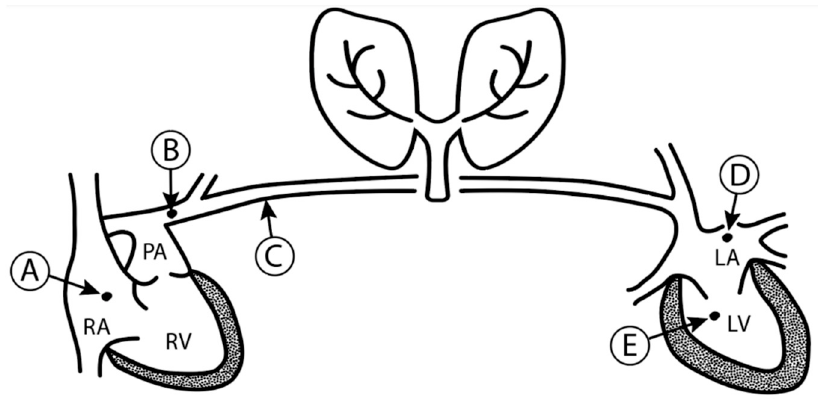
Figure 2. Pressure Relationships. A patient can have falsely elevated central venous pressure (A) in the setting of any of the following: Left ventricular hypertrophy affecting left ventricular compliance (E), mitral valve disease increasing left atrial pressure (D), pulmonary disease increasing alveolar pressure (C), pulmonary artery disease increasing pulmonary artery pressure (B), right ventricular hypertrophy affecting compliance of the right heart or tricuspid disease increasing right atrial pressure (A).